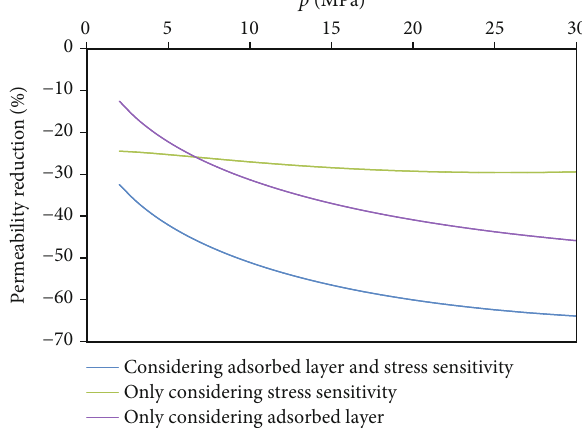
Figure 6: Contribution of slip fl ow, Knudsen di ff usion, and surface di ff usion to apparent permeability.